Question: Looking at the figure, what chart type is it?
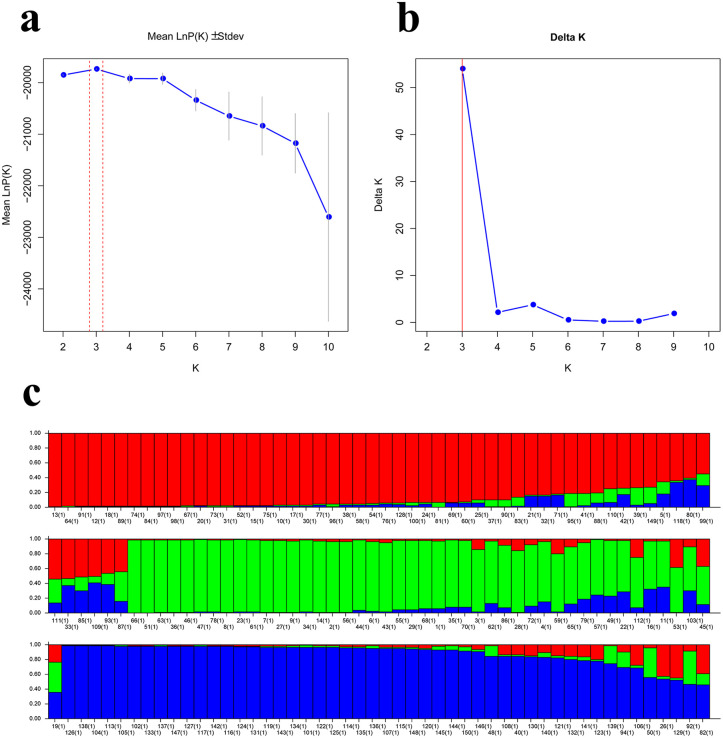
Answer: scatter